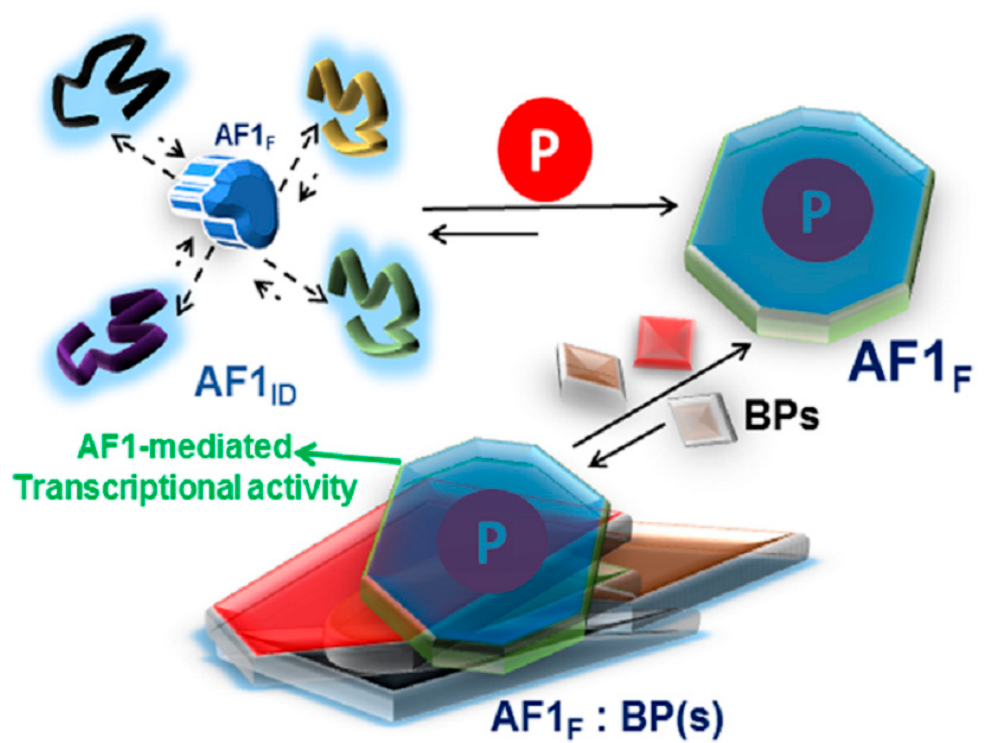
Figure 2. A proposed model of the effect of phosphorylation on the folding of intrinsically disordered (ID) AF1 domain of the glucocorticoid receptor. AF1 exists in equilibrium with mostly unstructured AF1 ID and a small fraction of folded (AF1 F ) conformers. Due to AF1’s site-specific phosphorylation (P), the equilibrium is shifted in favor of folded conformers. This structural rearrangement in AF1 creates surfaces well suited for interaction with coregulatory binding partner (BP) proteins (shown by different shapes and colors). The interaction with these BPs results in the regulation of AF1-mediated transcription of GR target gene(s). Based on references [62,72].